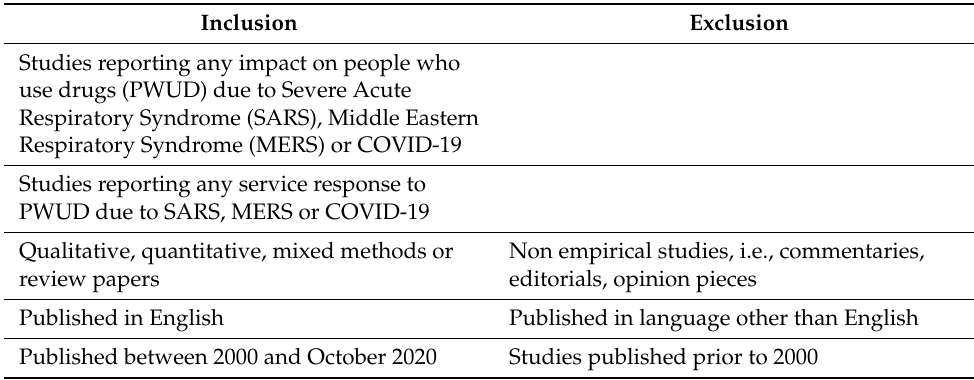
Table 1. Inclusion and Exclusion criteria.